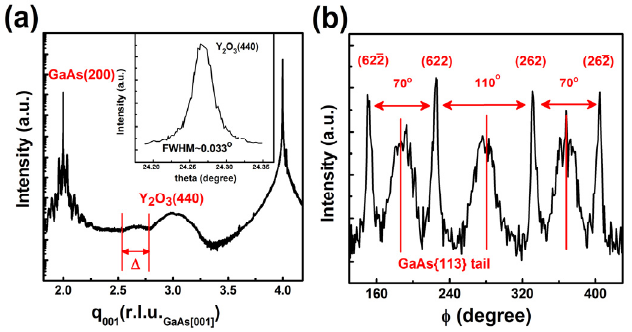
Figure 3. XRD ( a ) radial scans along the surface normal of ALD ‐ Y 2 O 3 film 2.3 nm thick on GaAs(001) ‐ 4 × 6 reconstructed surface; with ( b ) an azimuthal φ scan across the {622} reflections of ALD ‐ Y 2 O 3 film 5 nm thick on GaAs(001) ‐ 4 × 6. The inset in ( a ) is the θ‐ rocking curve across the Y 2 O 3 (440) reflection.